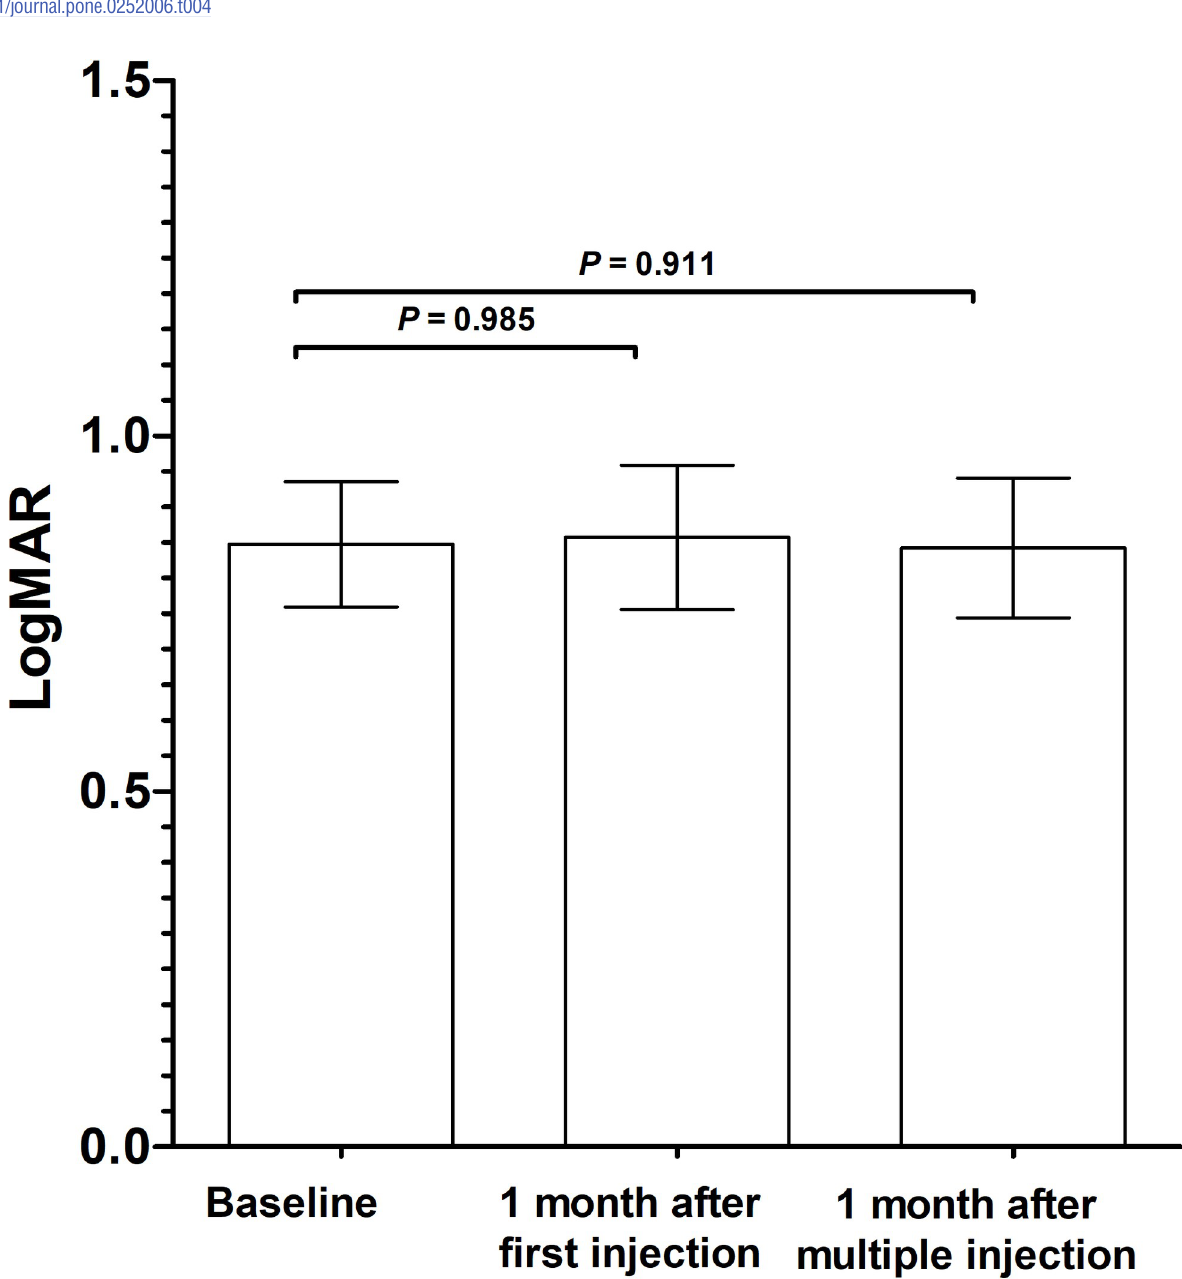
Fig 5. Change in best-corrected visual acuity (BCVA). The bars represent mean LogMAR BCVA and the error bars represent standard error of mean.